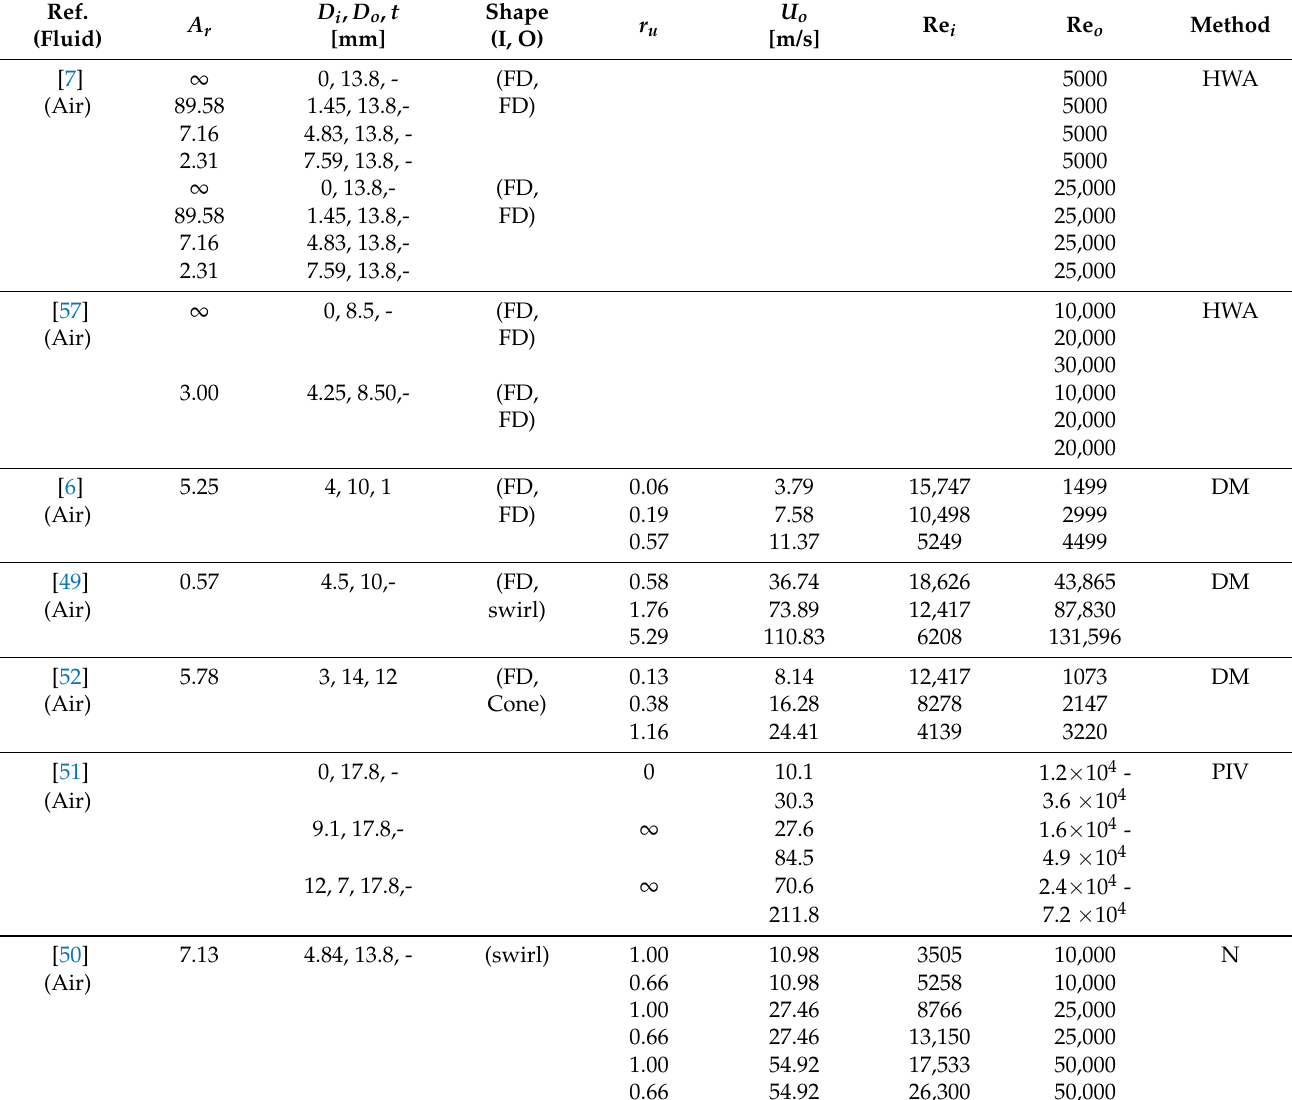
Table 4. Overview of literature publications on impinging coaxial jets: Flow field. Jet exit velocity profile shapes: “TH” and “FD” denote “Top hat” and “Fully developed” turbulent pipe flow, respectively. “I” and “O” denote “inner” and “outer” jet, respectively. Measurement technique: “HWA” (hot-wire anemometer), “DM” (Digital manometer), “PIV” (Particle image velocimetry), “N” (Numerical study). A dash indicates “data not provided”. Note that Re o in Celik and Eren [7] and Celik [57] is based on D o and the total mass flow rate through the inner and outer jets.